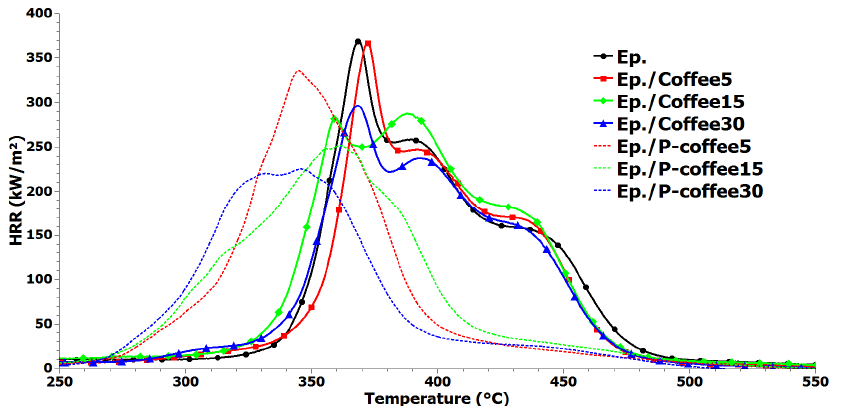
Figure 9. Heat release rate (HRR) curves for the neat epoxy and epoxy composites containing both Coffee and P-coffee obtained in PCFC test. Table 4. Summary results obtained in PCFC tests for the neat epoxy and epoxy containing Coffee and P-coffee.